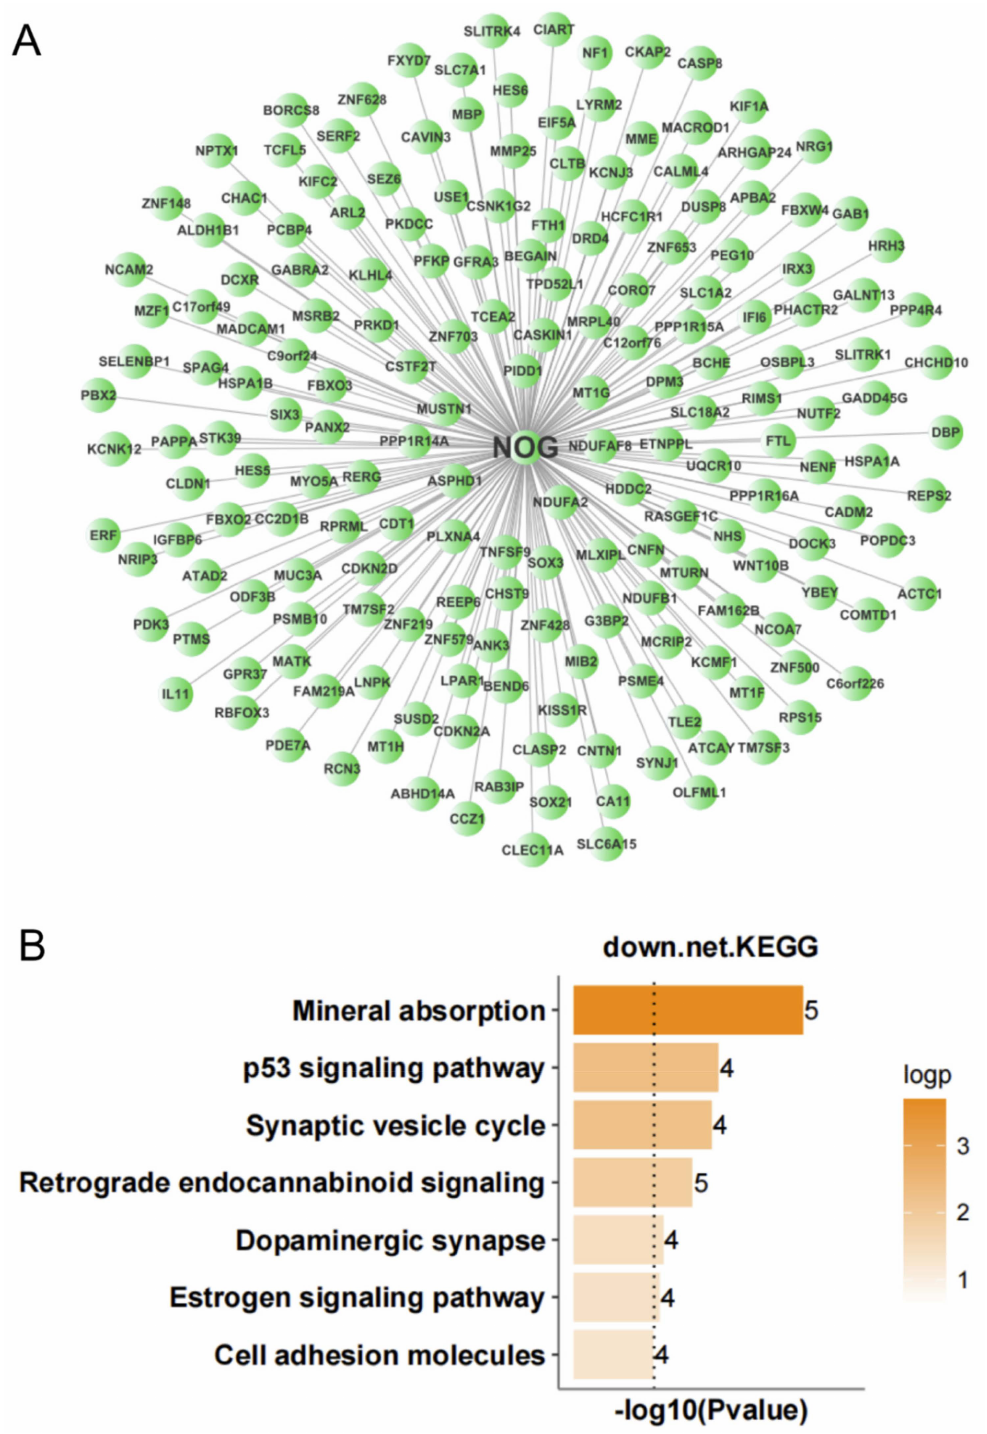
Figure 9. Expression regulation network and Kyoto Encyclopedia of Genes and Genomes (KEGG) analysis of down-regulated genes in nerve tissue of amyotrophic lateral sclerosis patients. ( A ) Network with NOG as the main regulatory factor. ( B ) KEGG analysis of network target genes with NOG as the main regulatory